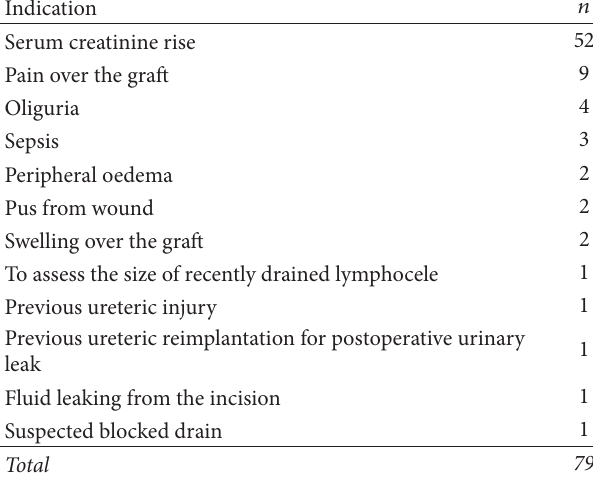
Table 1: Indications for urgent transplant ureteric stent removal. Indication Urinary tract infection